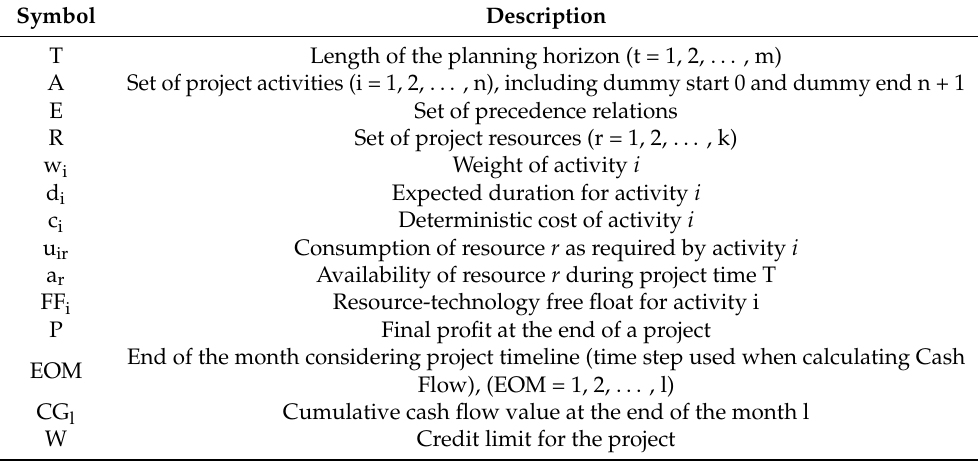
Table 3. Parameters and sets used in the optimization